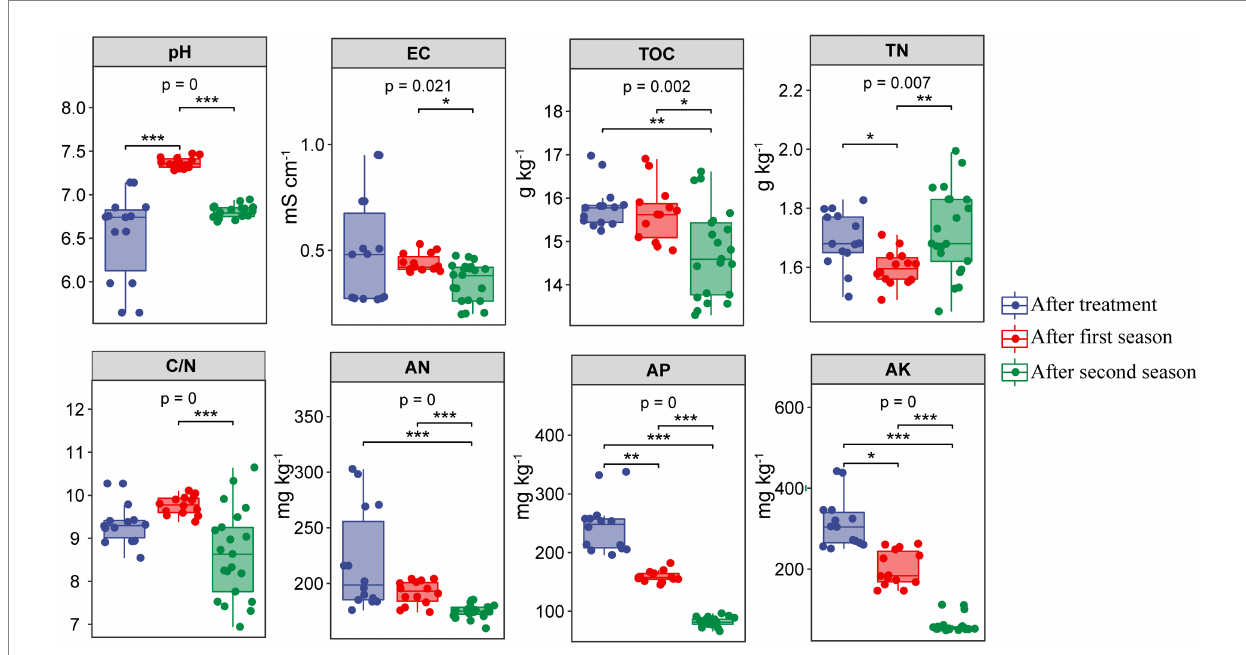
FIGURE 1 Chemical properties in different soils after RSD treatment and two planting seasons. EC: electric conductivity, TOC: exchangeable calcium, TN: total nitrogen, C/N: carbon to nitrogen ratio, AK: available nitrogen, AP: available phosphate, AK: available potassium. The significance of different groups was determined by the p values (ANOVA, Tukey’s HSD). * p < 0.05; ** p < 0.01; *** p <